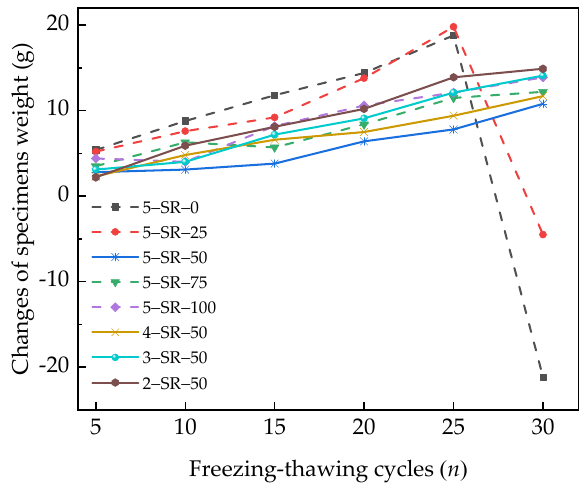
Figure 14. Changes in the weight of specimens under different freeze–thaw cycles.